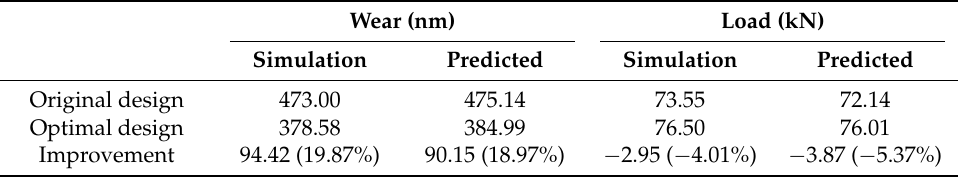
Table 6. Comparison of predicted and simulation results between original and optimal designs.